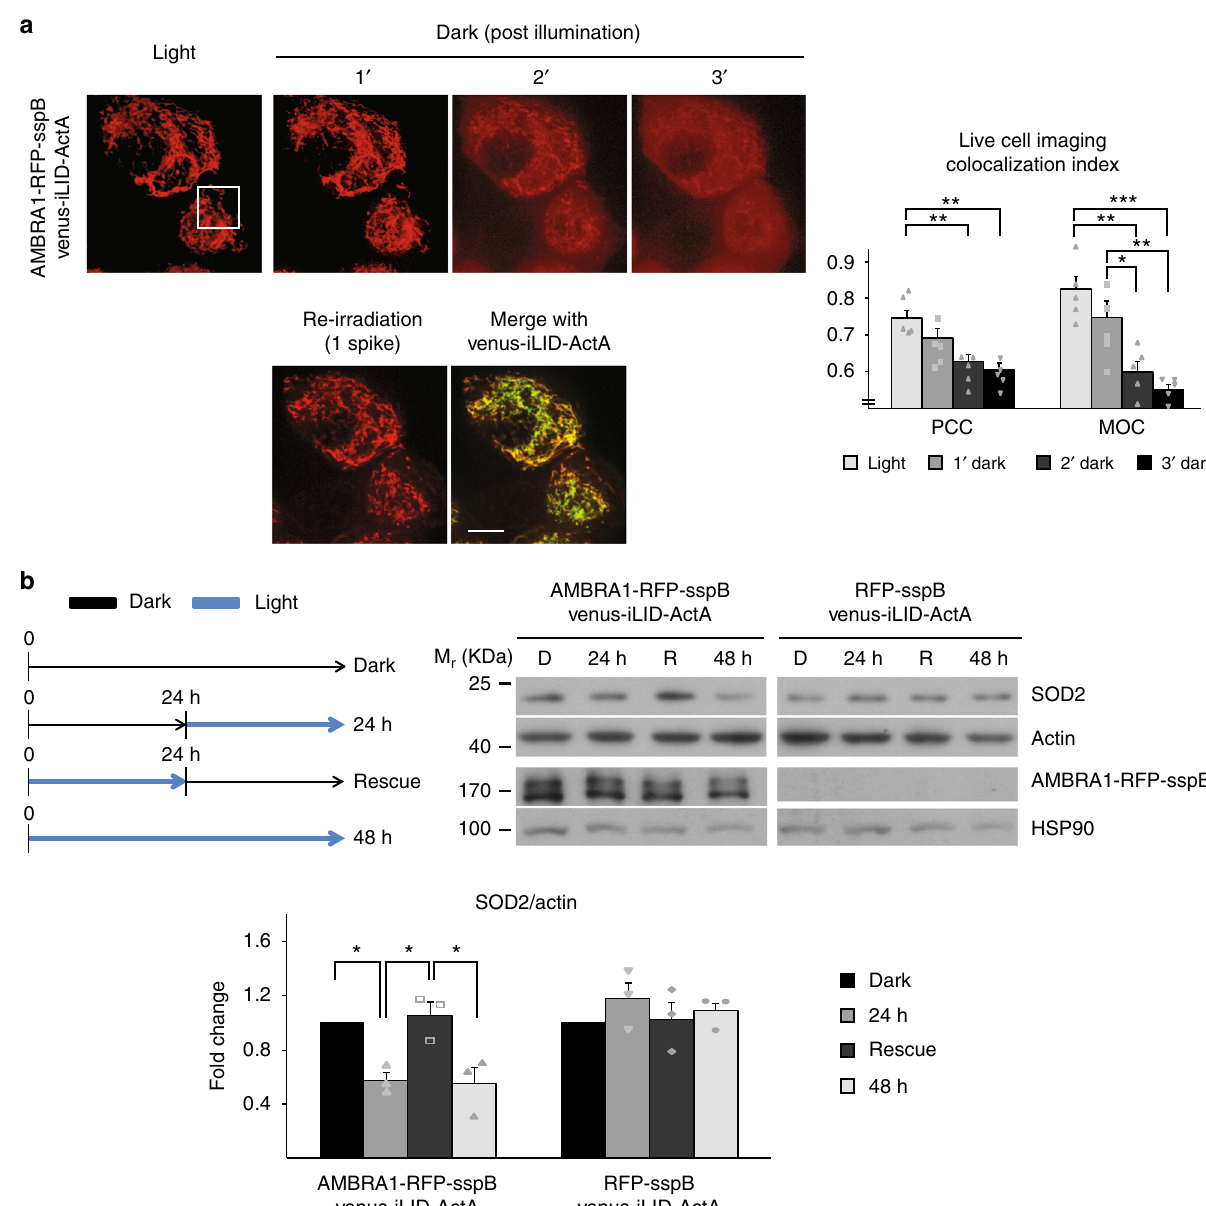
Fig. 3 AMBRA1-RFP-sspB-mediated mitophagy is reversible. a AMBRA1-RFP-sspB shuttling from mitochondria was assessed by live cell imaging in single Venus-iLID-ActA/AMBRA1-RFP-sspB overexpressing HeLa cells. Upon blue light irradiation AMBRA1-RFP-sspB was found at mitochondria. Subsequently, AMBRA1-RFP-sspB subcellular distribution was recorded every minute without blue light administration. After 3 min, one spike of blue light was reapplied. Images are the sum of a three frames Z-stack. PCC and MOC of the red over the green signal were quanti fi ed in ten random fi elds of fi ve independent experiments. For a ×4 magni fi cation of the inset see Supplementary Figure 13. Scale bar: 10 μ m. Data shown mean ± S.E.M. Hypothesis test: ANOVA test. * p < 5 × 10 − 2 . ** p < 10 − 2 . *** p < 10 − 3 . b Transfected HeLa cells were treated as follows: 48 h of dark (lane Dark or D), 24 h of dark + 24 h pulsed blue light (1 s light + 1 min dark, lane 24 h), 24 h of pulsed blue light + 24 h of dark state (lane Rescue or R), and 48 h of pulsed blue light only. Cell lysates were loaded on a polyacrylamide gel and immuno-blotted. Levels of the mitochondrial marker SOD2 were investigated; AMBRA1-RFP-sspB was detected to verify the rate of overexpression. Actin and HSP90 were used as loading controls of the two gels, respectively. The graph shows the normalized densitometric SOD2 over actin ratio in three independent experiments. The experiments were repeated in Venus-iLID-ActA/RFP-sspB overexpressing HeLa cells as a control (right panel). Data shown: mean ± S.E.M. Hypothesis test: ANOVA test. * p < 5 × 10 − 2 . M r (kDa): Relative molecular mass expressed in kilodalton. Source data are provided as a Source Data fi Primed by this evidence, we fi rst veri fi ed mitophagy stimula- In these cells, mito-aggresome formation was con fi rmed tion upon pulsed blue light exposure in Venus-iLID-ActA/ (Fig. 6a), as well as the decrease of mitochondrial mass as AMBRA1-RFP-sspB co-expressing embryonic telencephalic measured by the protein levels of the marker HSP60 (Fig. 6b, left nAïve (ETNA) cells, a line derived from murine E14 striatum panel). In our system, mitochondrial damage primed by primordia neurons 34 . Subsequently, we investigated its protective PQ seemed not to trigger mitophagy in basal conditions, action upon PQ-mediated damage (Fig. 6). whilst it robustly potentiated mitochondrial loss when